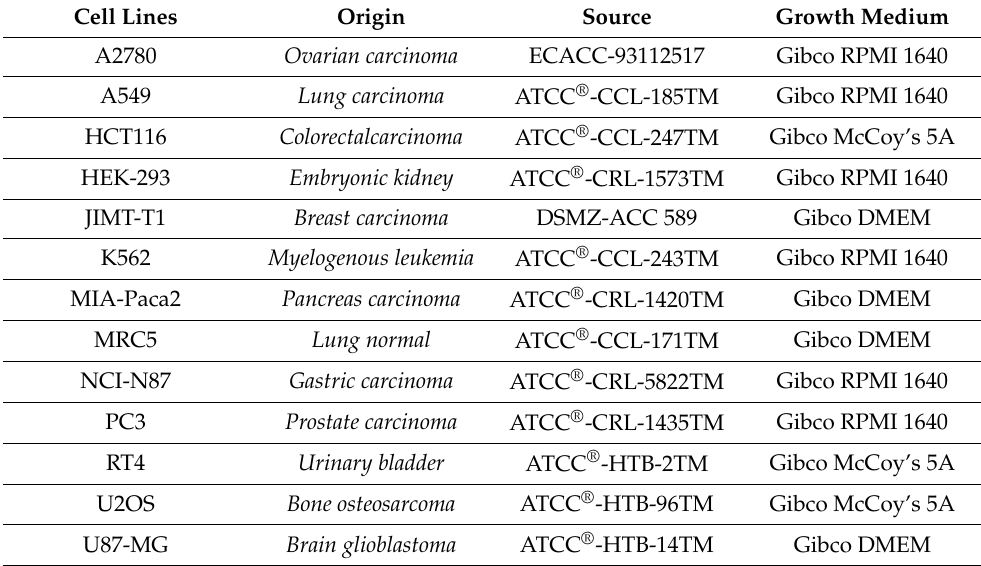
Table 1. The origin, source and growth medium of 13 cancer cell lines used in the cytotoxicity test.